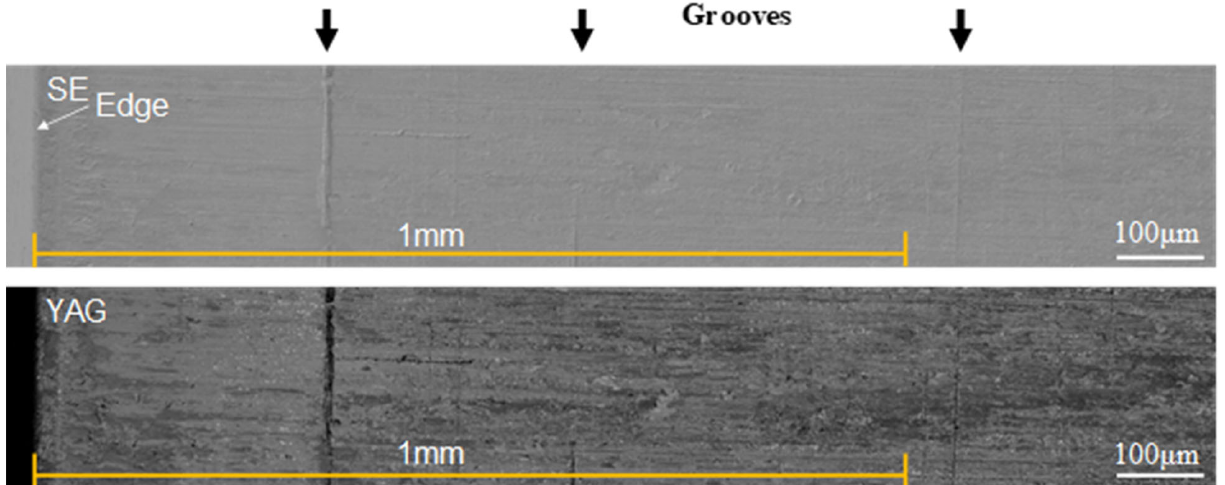
Figure 6. SEM and YAG images of the punch side surface from the punch edge to a position 1 mm away from this. SEM and YAG analyses were performed around the punch edge and at a particular posi ‐ tion away from this edge at X = 1 mm. Figure 7 compares the microstructures analyzed at both positions. Adhesive films, indicated by “a” in Figure 7, formed as a layer with a length of 20 (cid:31)m and a width of 50 (cid:31)m in the vicinity of the punch edge. This layer formed long stripes, formed along the axial direction or in the X ‐ axis.